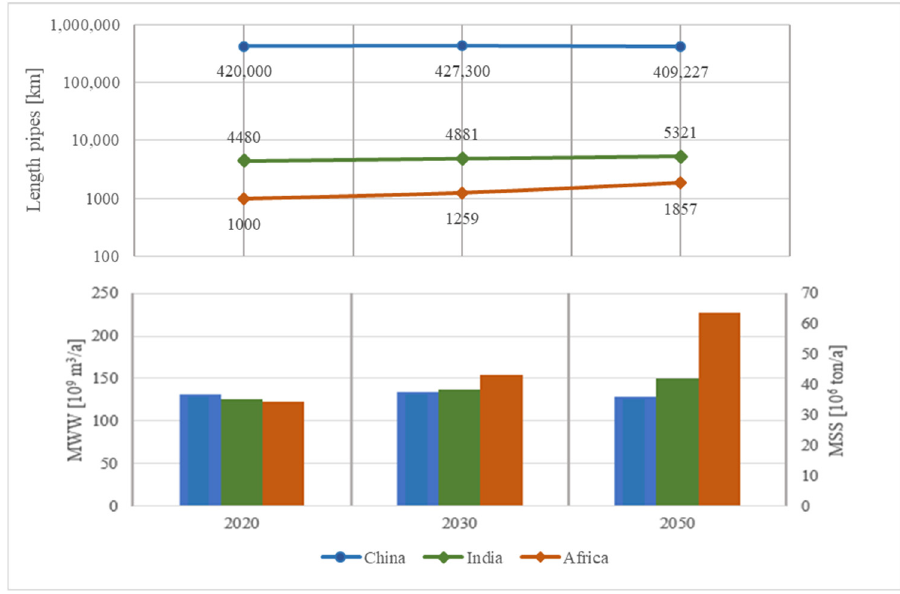
Figure 3. Infrastructure effort estimated in terms of length of sewers, MWW and MSS for China, India, and Africa.